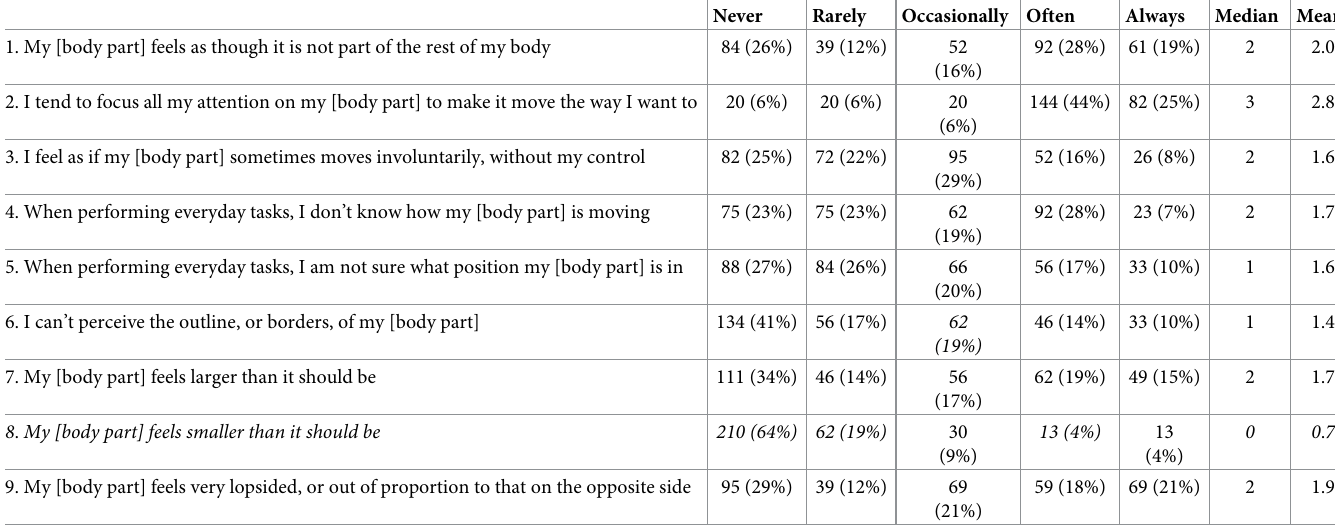
Table 2. Response frequencies of the 9 FreBAQ-general items.